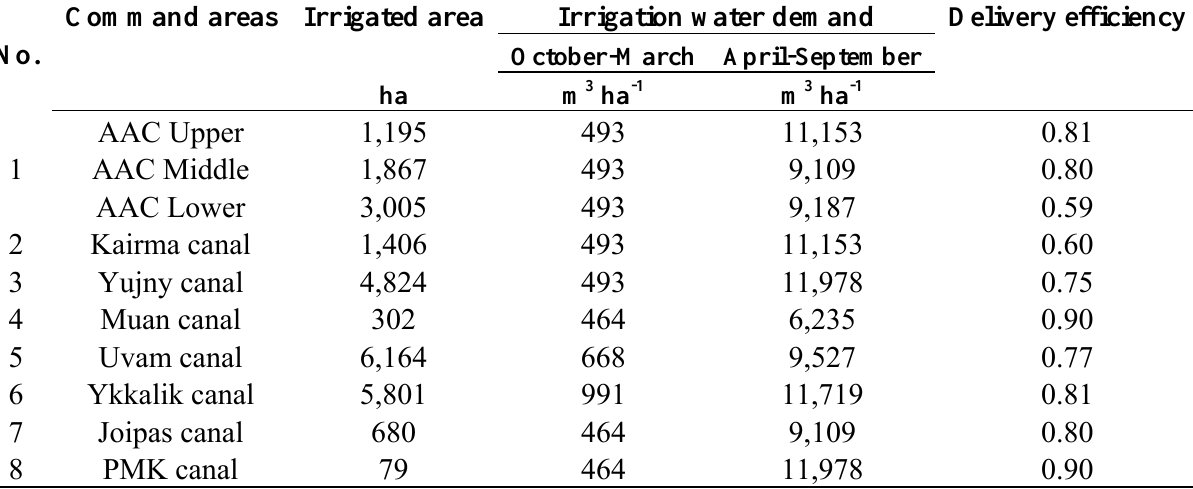
Table 2. Irrigation water demands in the Akbura River basin in the mean water